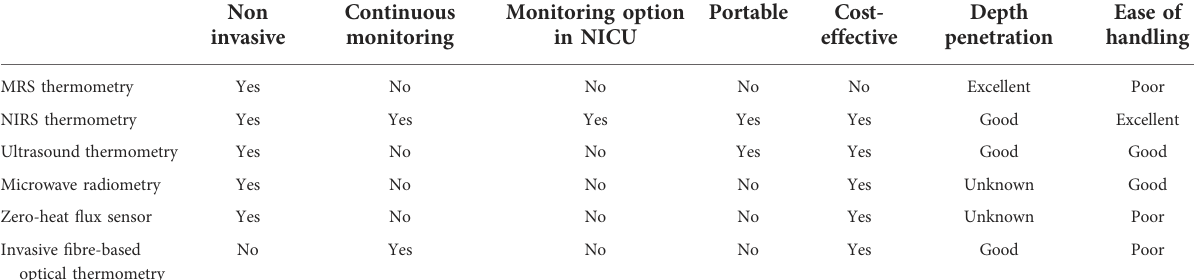
TABLE 1 Different methodologies for brain temperature